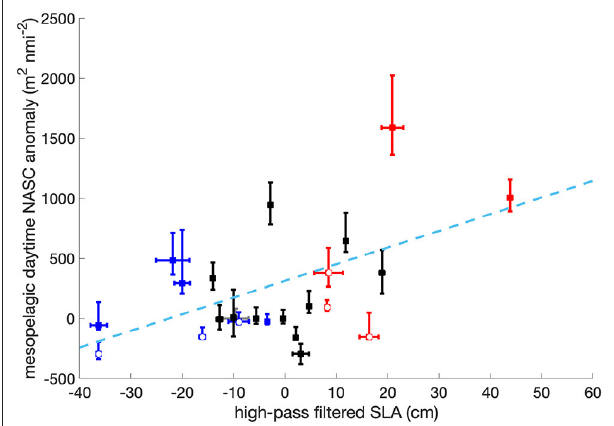
FIGURE 3 | Relationship between high-pass filtered SLA and mesopelagic daytime NASC seasonal anomaly. Blue dots represent sampling locations within the core or the periphery of cyclonic eddies, red dots represent locations within the core or the periphery of anticyclonic eddies, black dots represent out-of-eddy stations and the gray dot refers to N2S3 (SLA ∼ − 10 cm), excluded from this analysis. Empty dots indicate stations at eddy peripheries whereas filled dots indicate stations within eddy cores. Errorbars refer to the standard deviation of the SLA extracted for the locations of the acoustic sampling and to the propagated uncertainty from the 15 to 85 quantiles for the NASC anomaly. The dashed line represents the linear relationship fitting the eddy stations ( R 2 = 0.37, p -value =